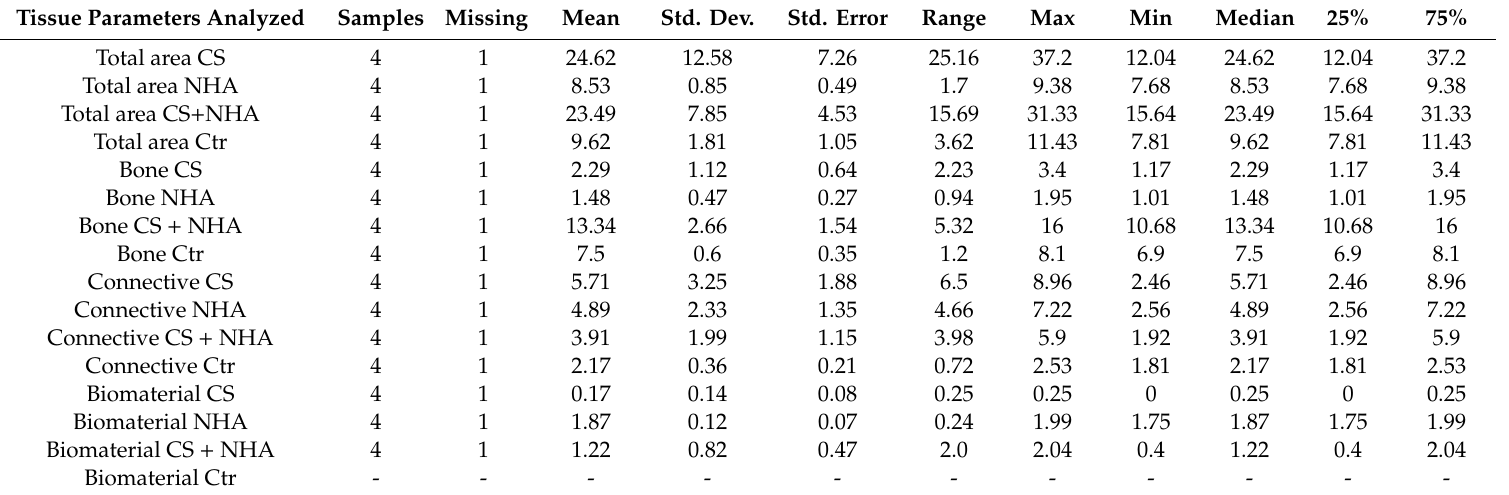
Table 2. Area of the analyzed segments (mm 2 ).